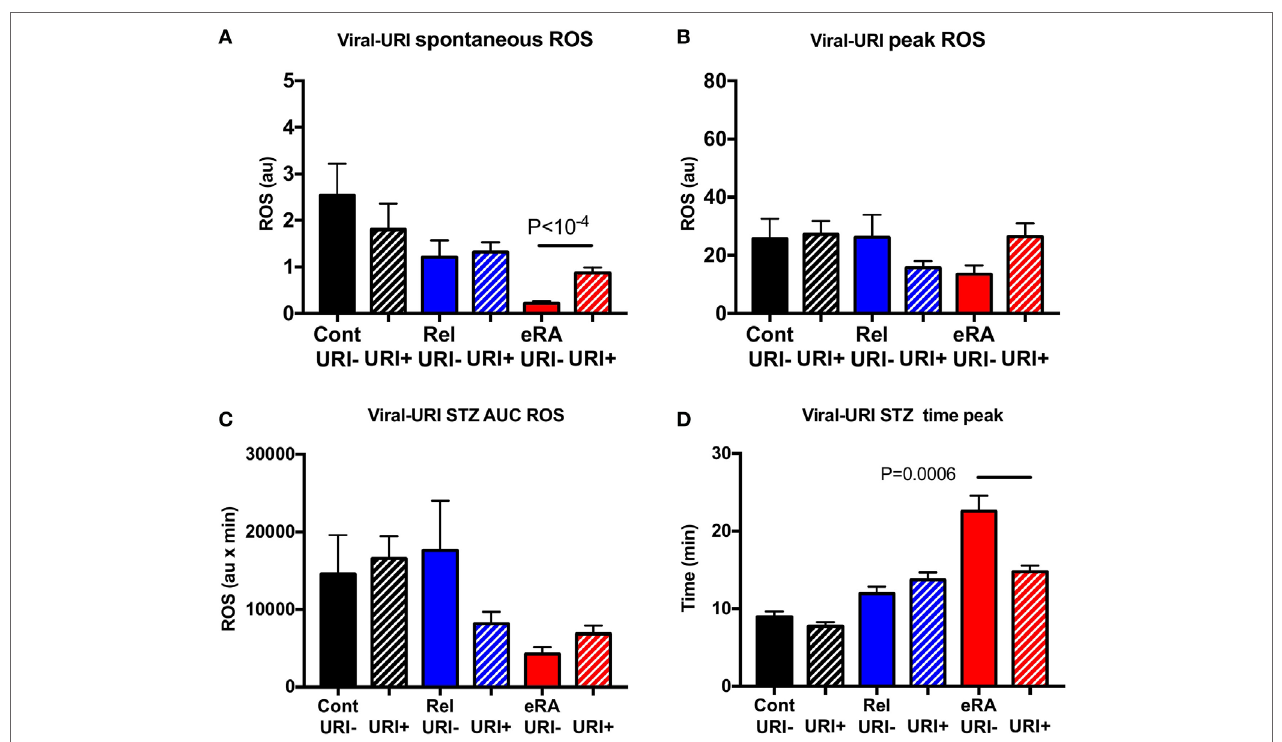
FigUre 5 | Impact of a history of viral upper respiratory tract infection symptoms (V-URI) in the year preceding sample collection in granulocyte reactive oxygen species (ROS) production: spontaneous (a) , after serum-treated zymozan (STZ) stimulation at peak (b) , area under the curve (AUC) (c) , and time to reach peak ROS production (D) . Healthy controls (Cont), rheumatoid arthritis (RA) first-degree relatives (Rel), and untreated RA patients at onset (early RA). Statistics are indicated when P ≤